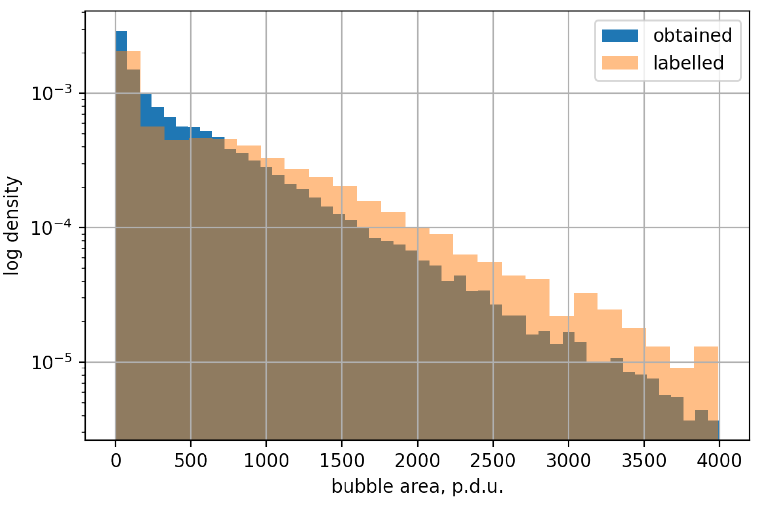
Figure 20. Bubble area distribution on a logarithmic scale.